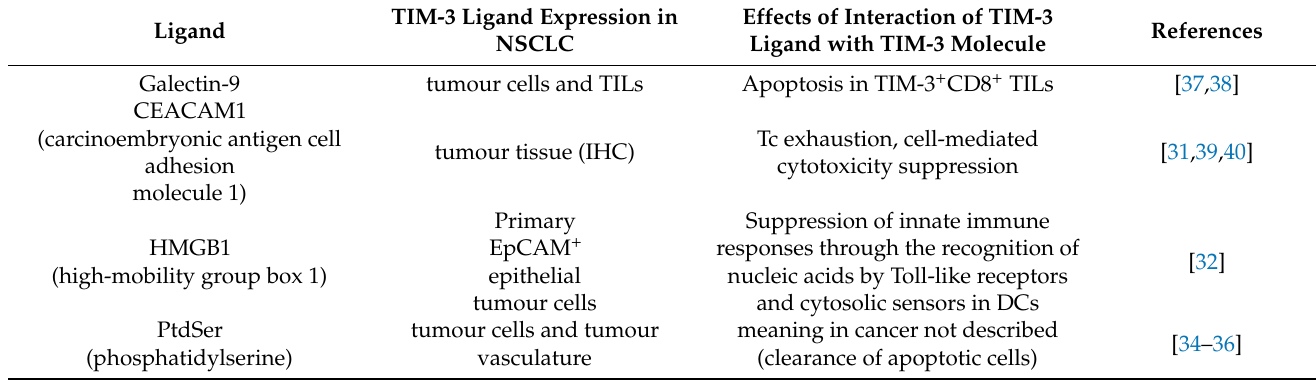
Table 3. TIM-3 ligands and their role in